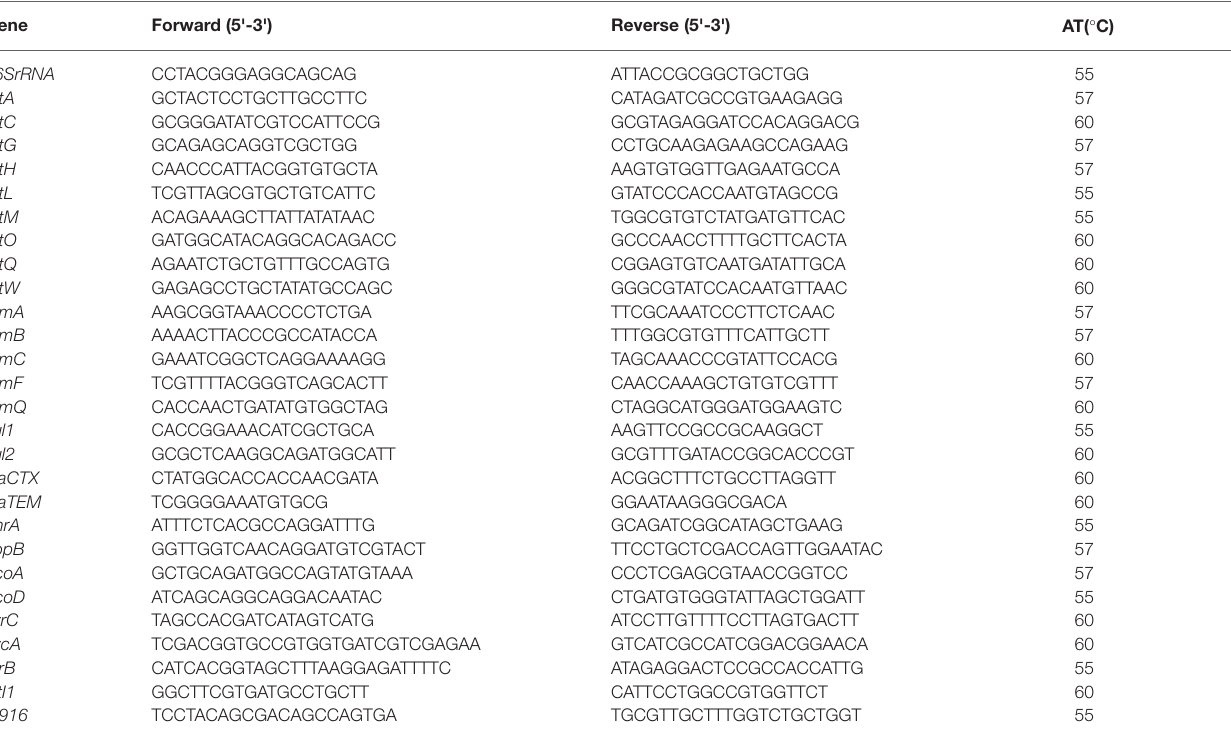
TABLE 1 | PCR primer sequences and annealing